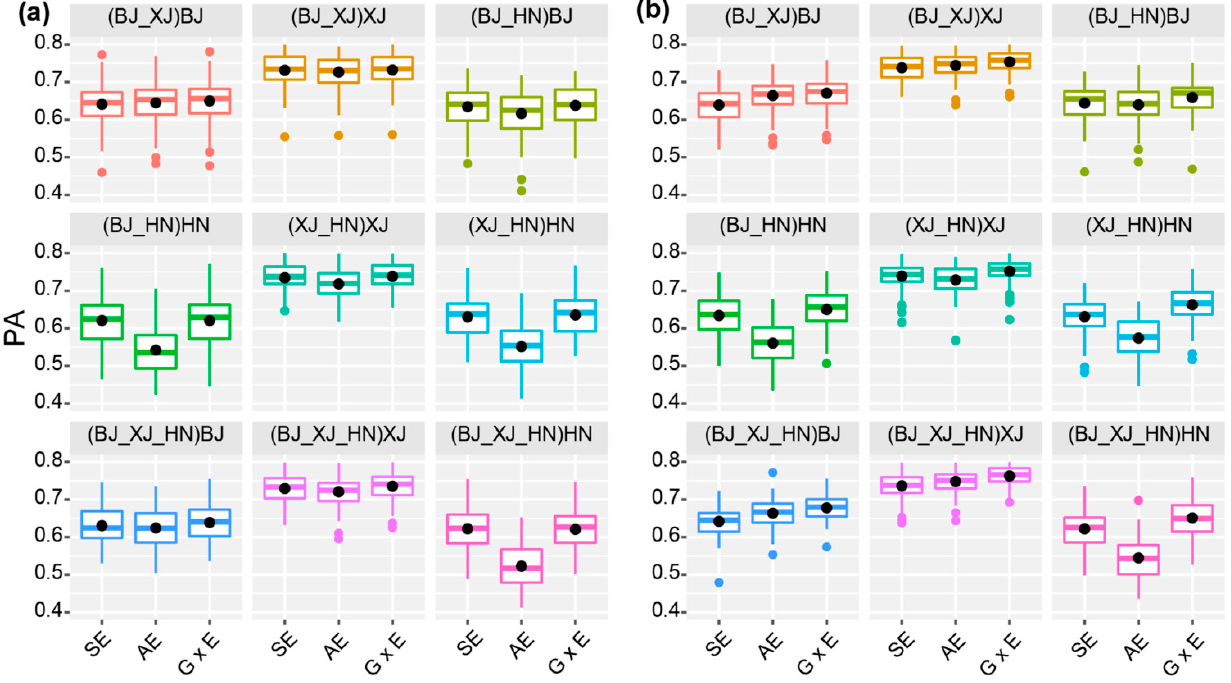
Figure 3. PA of the SE, AE, and G × E models for CV1 ( a ) and CV2 ( b ), respectively. The data inside and outside of brackets are the training, and validation datasets, respectively.